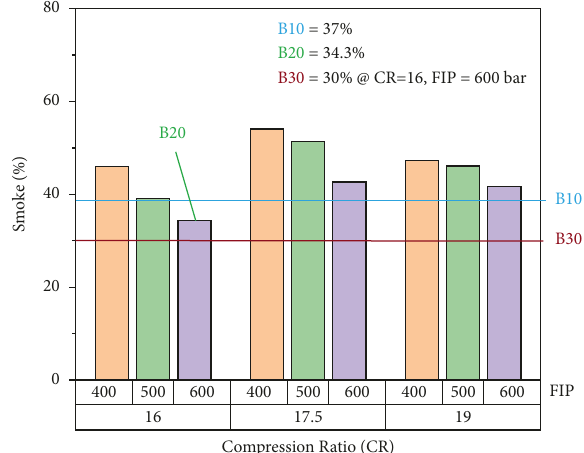
Figure 11: Smoke opacity for B20 blend at various FIPs and CRs.